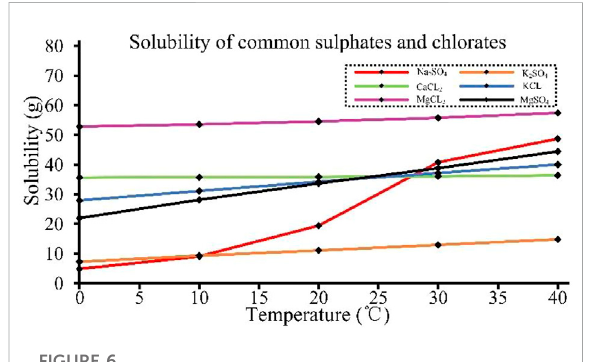
FIGURE 6 Solubility of common sulfates and chlorates along the